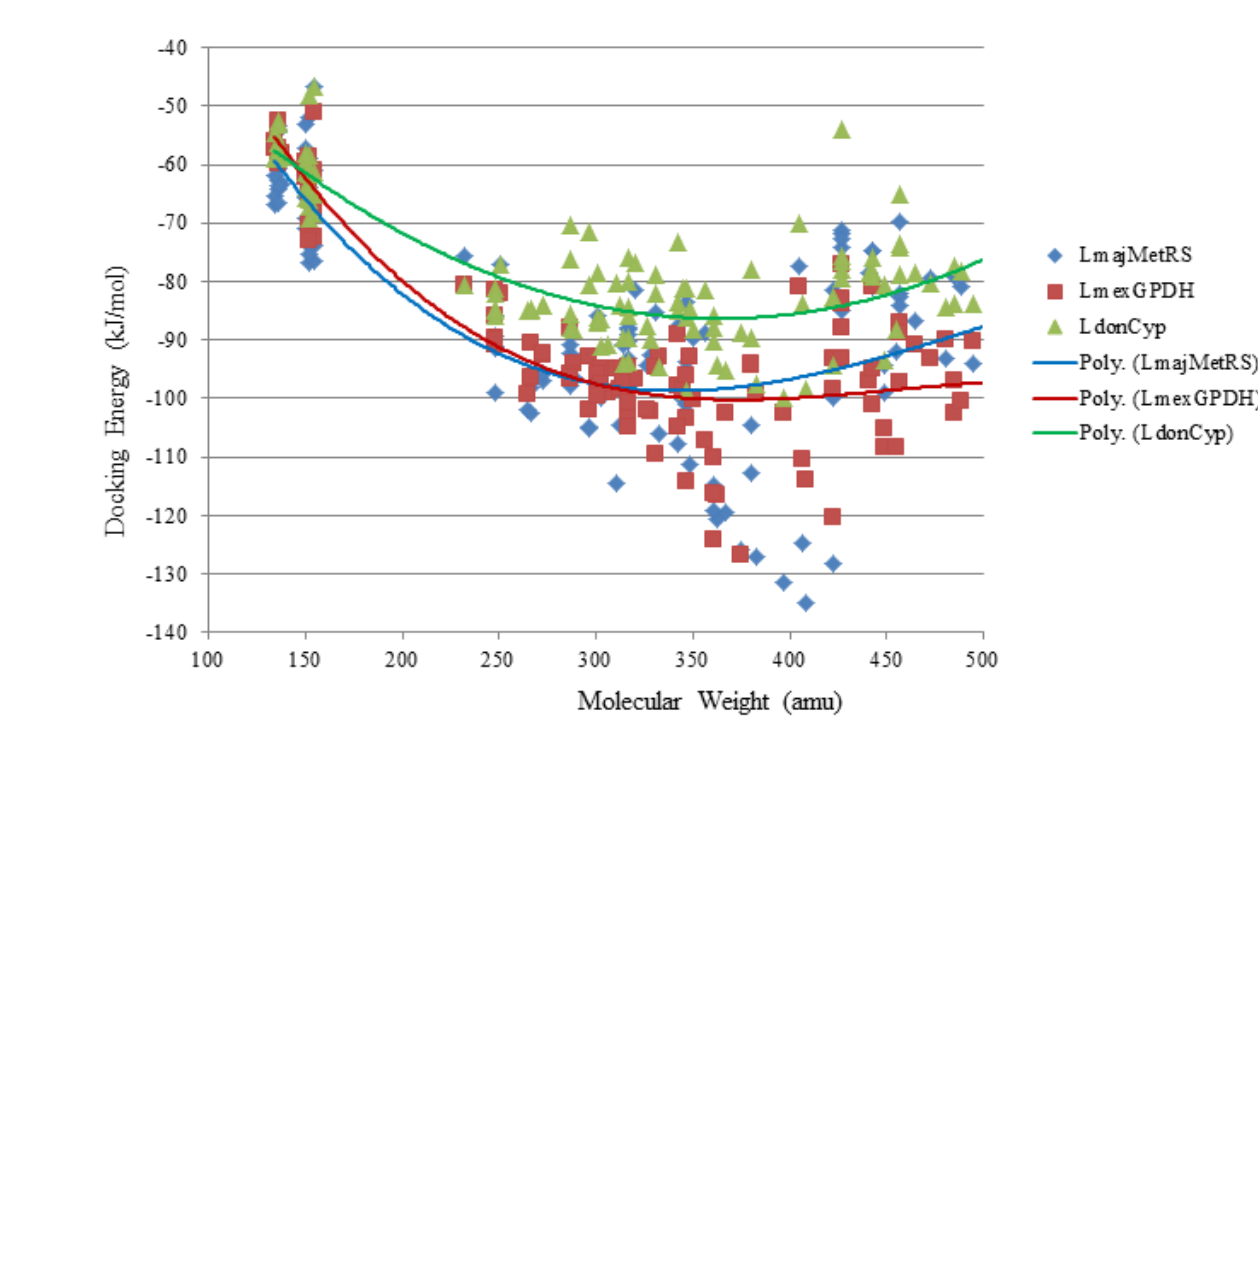
Figure 29. Plots of docking energies vs. molecular weights for representative isoprenoids with three Leishmania protein